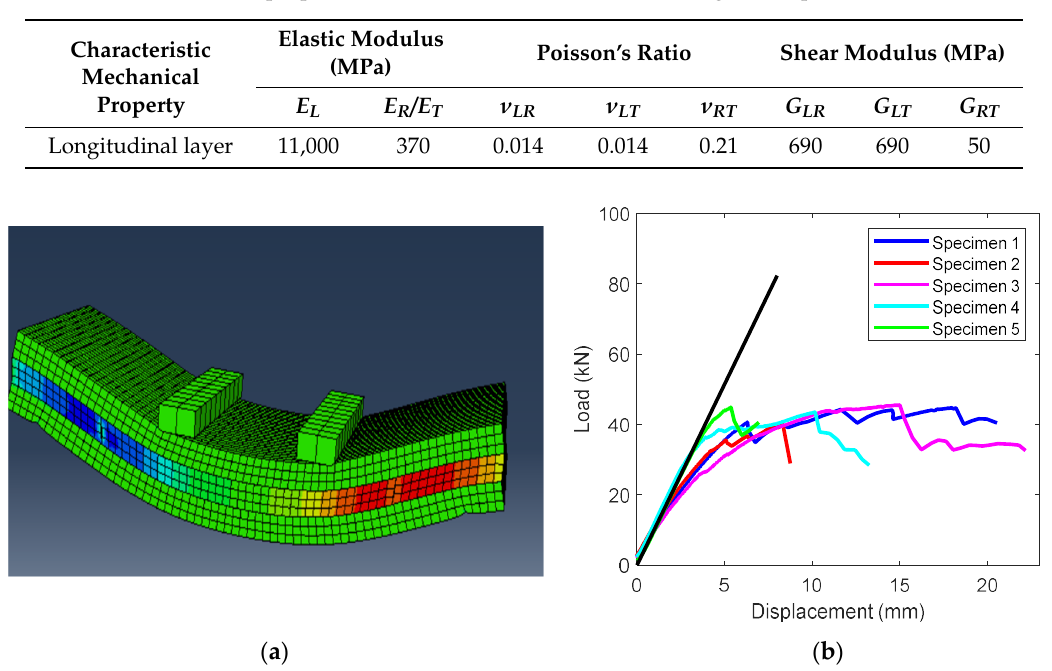
Table 4. Elastic modulus values used for the analytical methods for 3 layered CLT. Engineered Wood Product